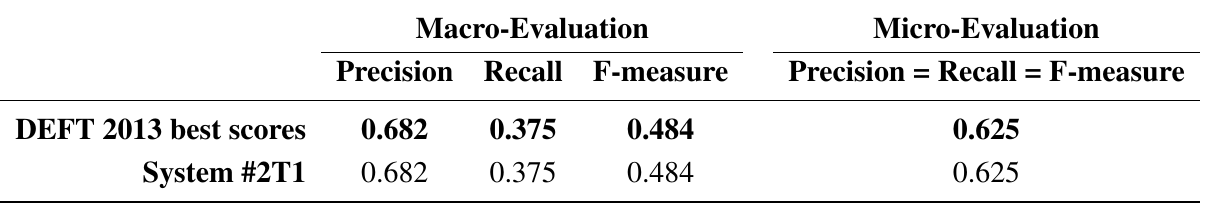
Table 9. Results obtained by system #2T1 on test corpus on task